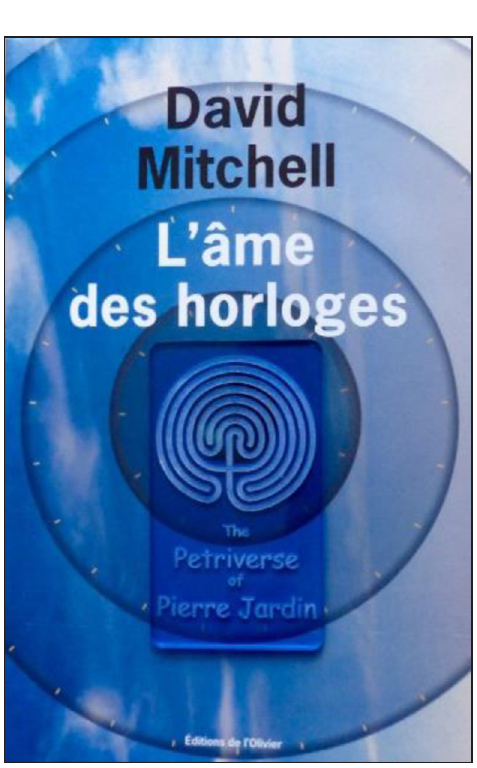
Figure 9: The Cretan labyrinth of Pierre Jardin egresses into the labyrinth of The Bone Clocks . Photo: Paul